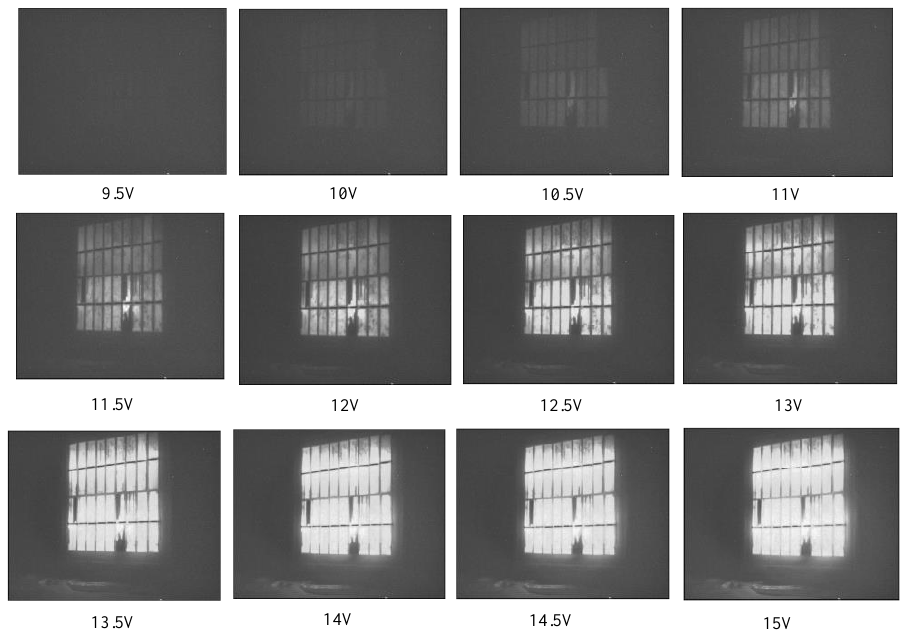
Figure 8. Images I of polycrystalline silicon photovoltaic panel with different bias voltages.